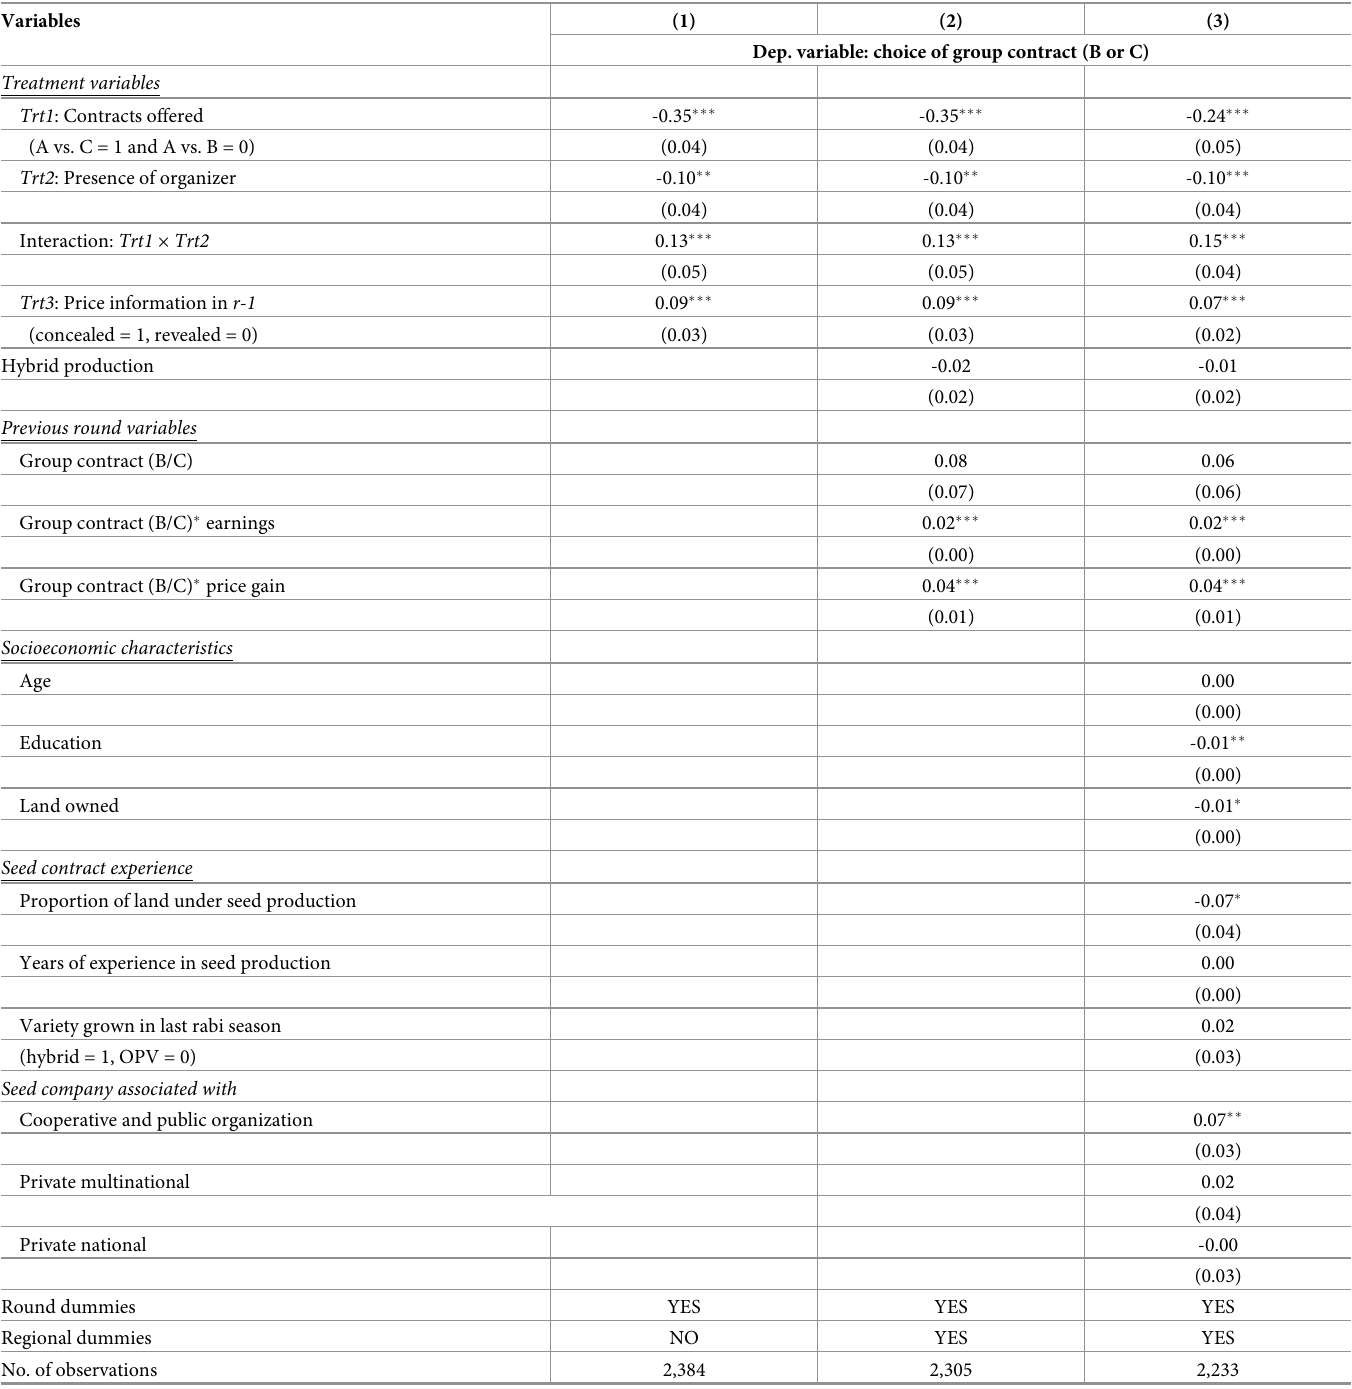
Table 4. Determinants of producers’ choice of the group